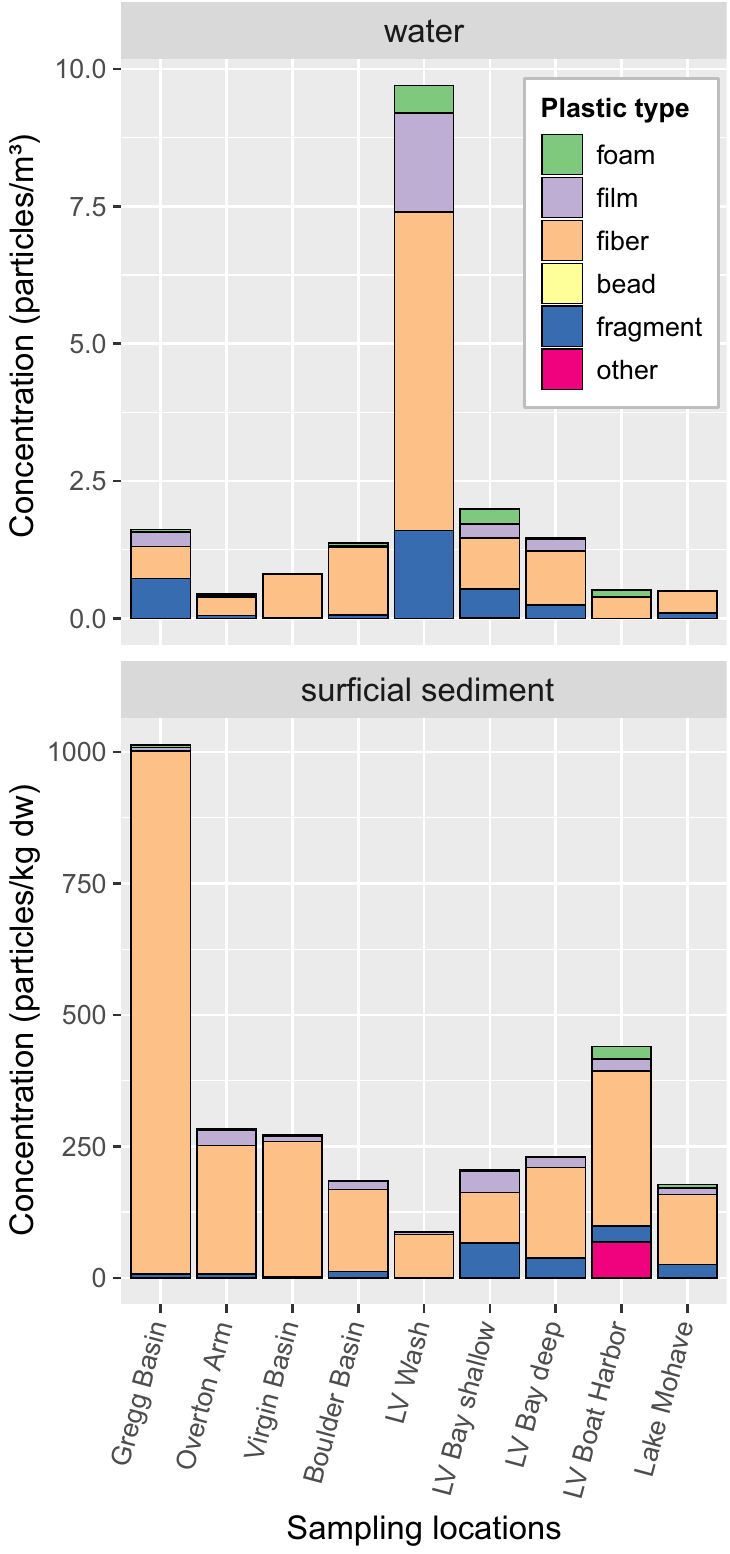
Fig 4. Concentrations of different microplastic types in water and surficial sediment samples, Lake Mead and Lake Mohave, 2017. dw, dry weight; LV, Las Vegas.